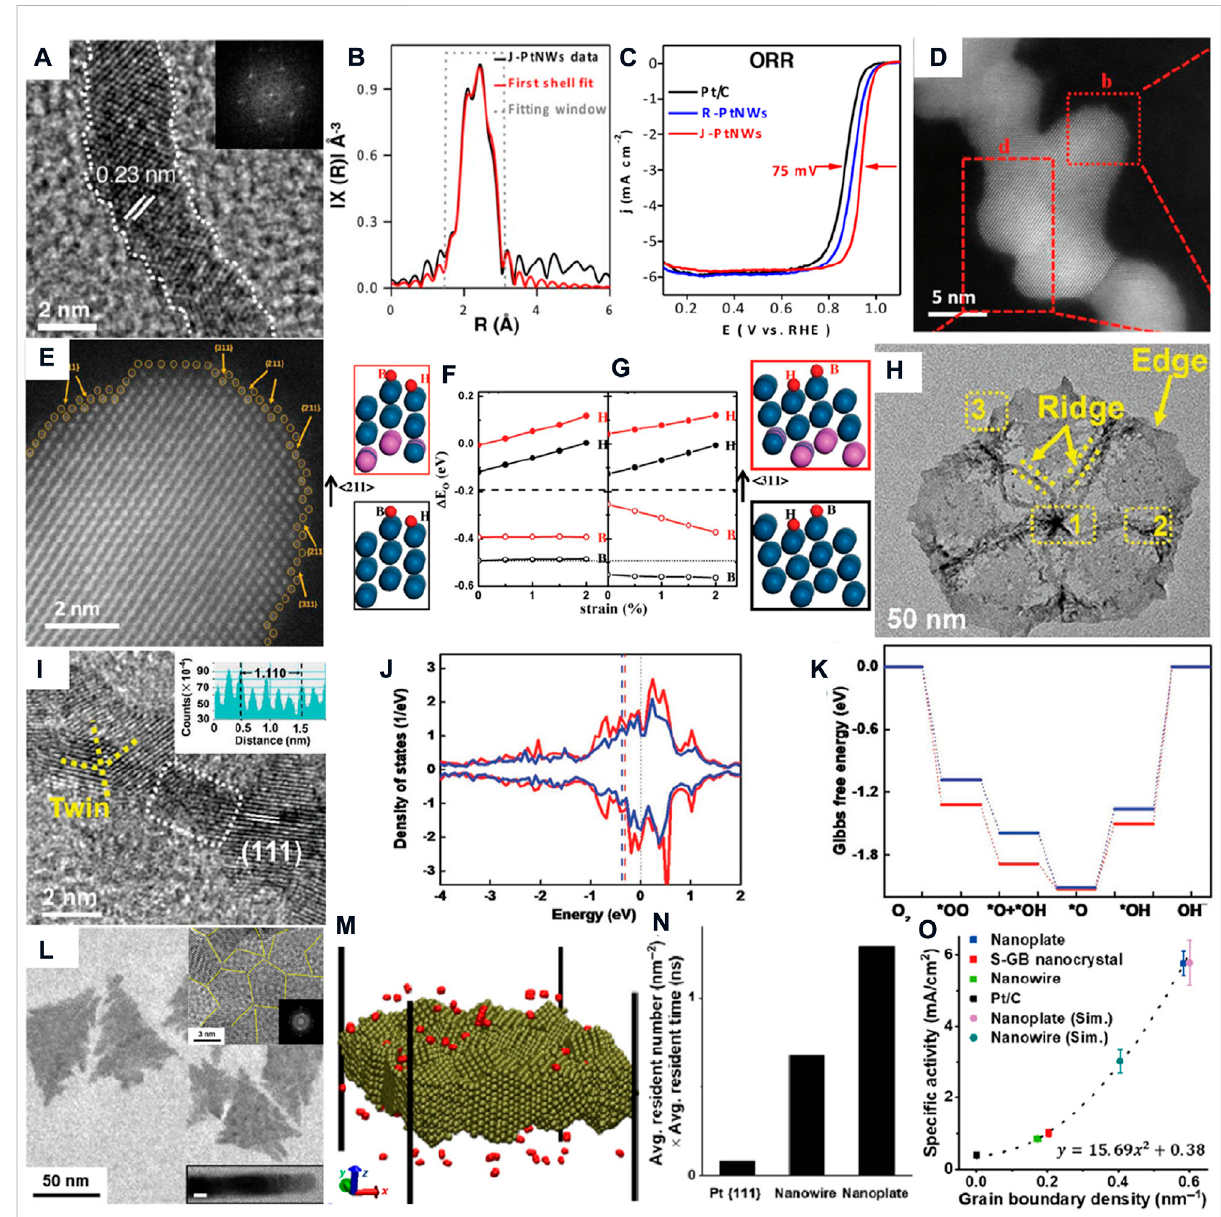
FIGURE 1 (A) HRTEM image and (B) Pt L 3 edge FT-EXAFS spectrum of ultra fi ne jagged Pt nanowires; (C) LSV curves for the selected contrast catalyst (Li et al., 2016). (D) HAADF-STEM and (E) enlarged b red square images of Pt-skin zigzag-like Pt 3 Fe nanowires; DFT calculation of oxygen adsorption energy on (F) (211) and (G) (311) surfaces (Luo et al., 2018). (H) TEM and (I) HRTEM images of Pt – Cu – Mn ultra fi ne nanoframes; (J) bonding (Red) and antibonding (blue) states, respectively; (K) free energy of pristine (red) and compressed (blue) surfaces (Qin, et al., 2020). (L) TEM and HRTEM images of ultrathin Pt nanoplates; (M) Slab lattices of the Pt nanoplate; (N) product of the average oxygen resident number and time in different assembled nanostructures; (O) quantitative simulation curve between speci fi c activities of the ORR and the grain boundary densities (Zhu et al.,